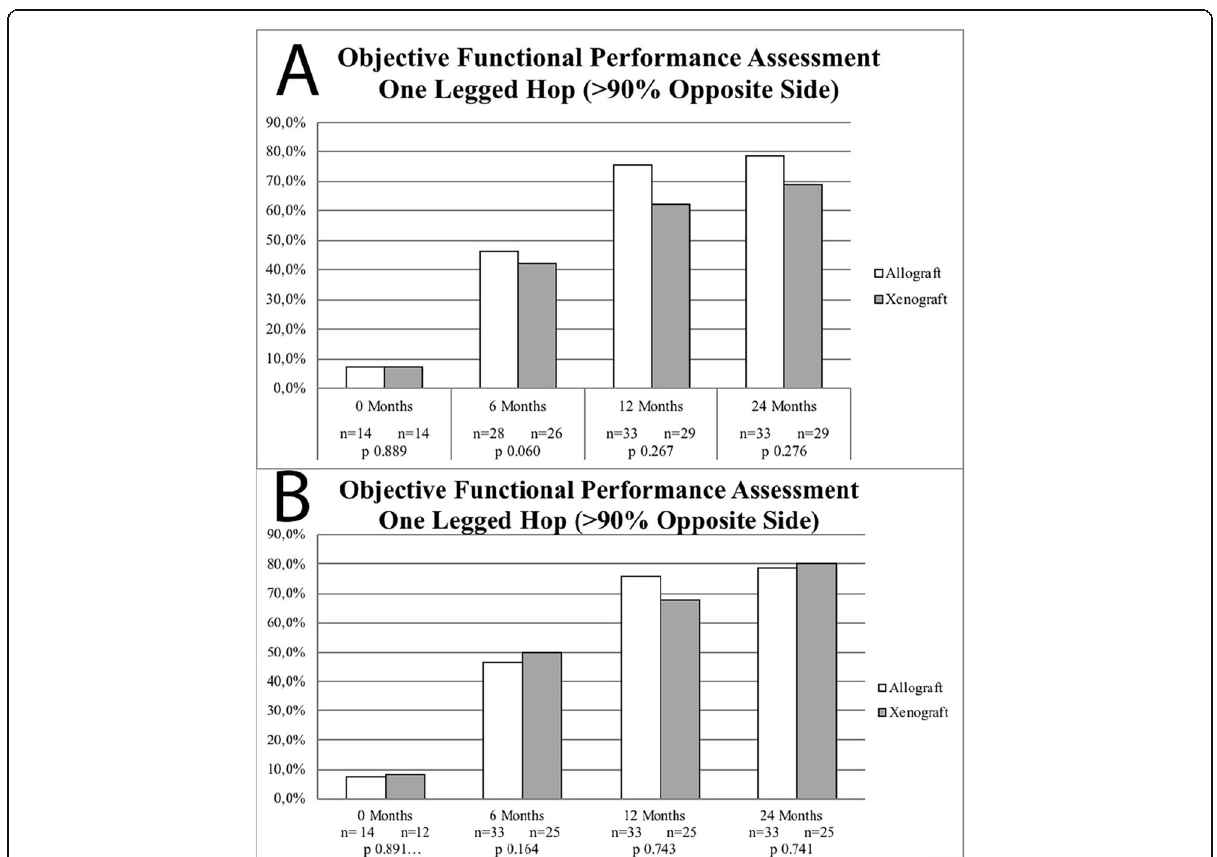
Fig. 2 Graft Functional Performance Assessment (One Leg Hop Test) - a , Missing/Contaminated Graft Subjects Included (LOCF); b , Missing/Contaminated Graft Subjects Excluded. No statistically significant differences were reported between study groups in both analysis (intention-to-treat vs. per